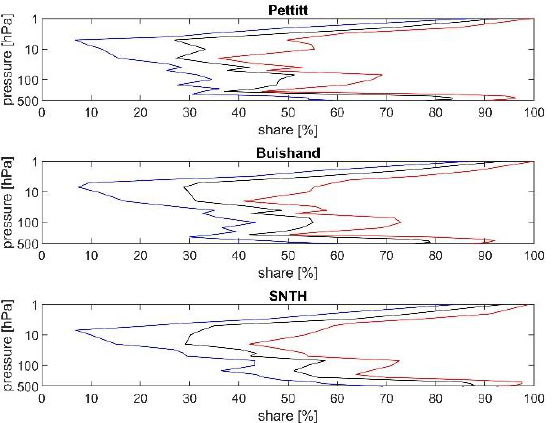
Figure 1. Vertical profile of average (black), minimal (blue) and maximal (red) share of discontinuities to all grids from all months from MERRA-2 for the Pettitt test ( upper panel ), the Buishand test ( middle panel ) and the Standard Normal Homogeneity test (SNTH, lower panel ).